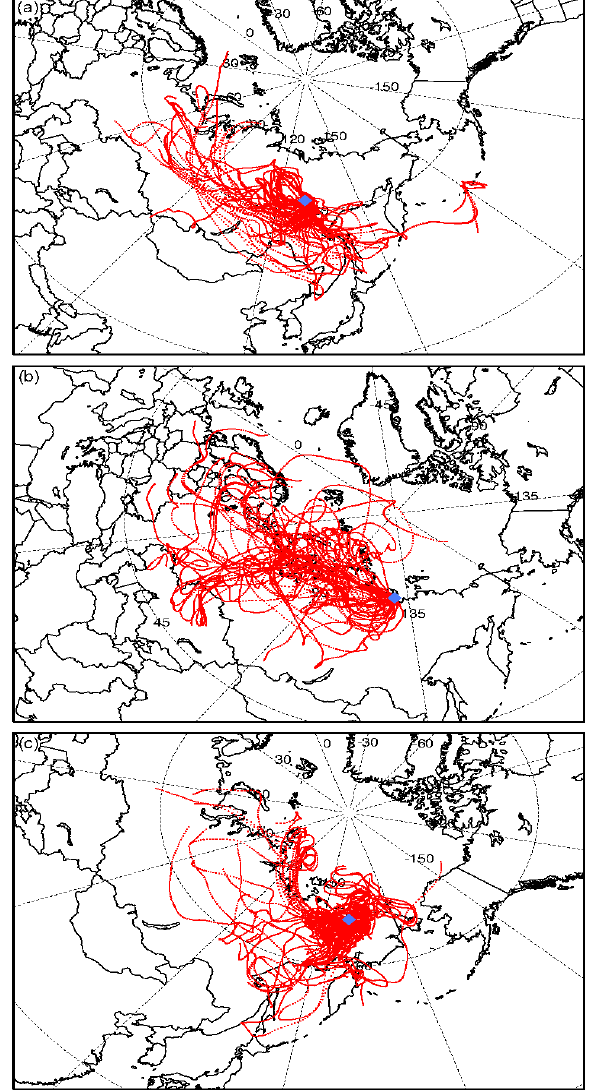
Fig. 6. Isentropic, 10 day back trajectories from HYSPLIT IV ini-